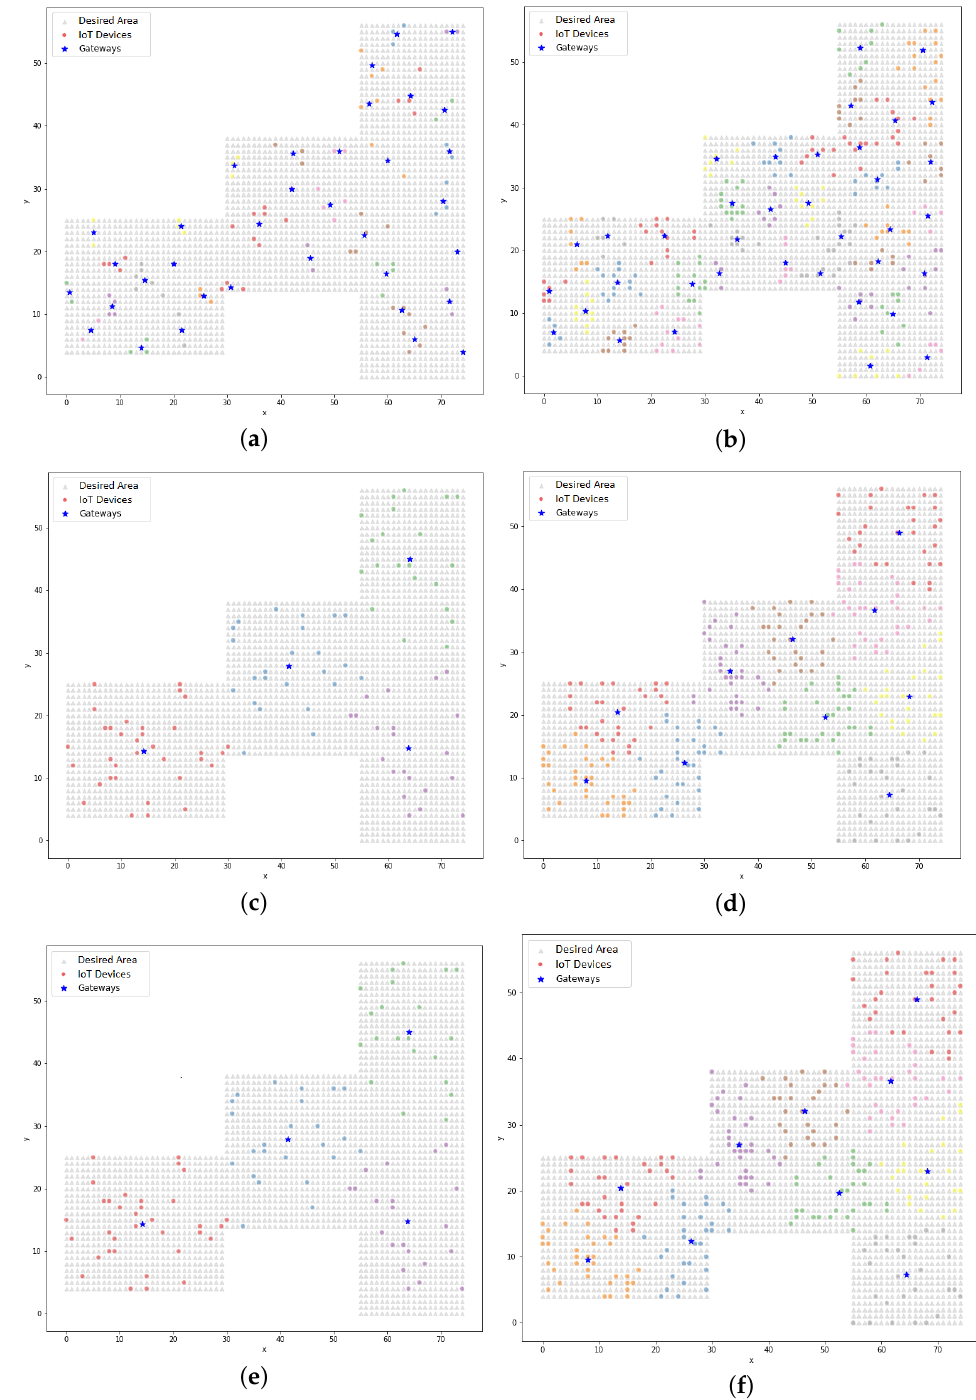
Figure 10. The clustering of IoT devices and their respective gateways using the K-means model: ( a ) BLE technology with 100 devices and 35 gateways; ( b ) BLE technology with 300 devices and 37 gate- ways; ( c ) Wi-Fi technology with 100 devices and 4 gateways; ( d ) Wi-Fi technology with 300 devices and 10 gateways; ( e ) LoRa technology with 100 devices and 4 gateways; ( f ) LoRa technology with 300 devices and 10